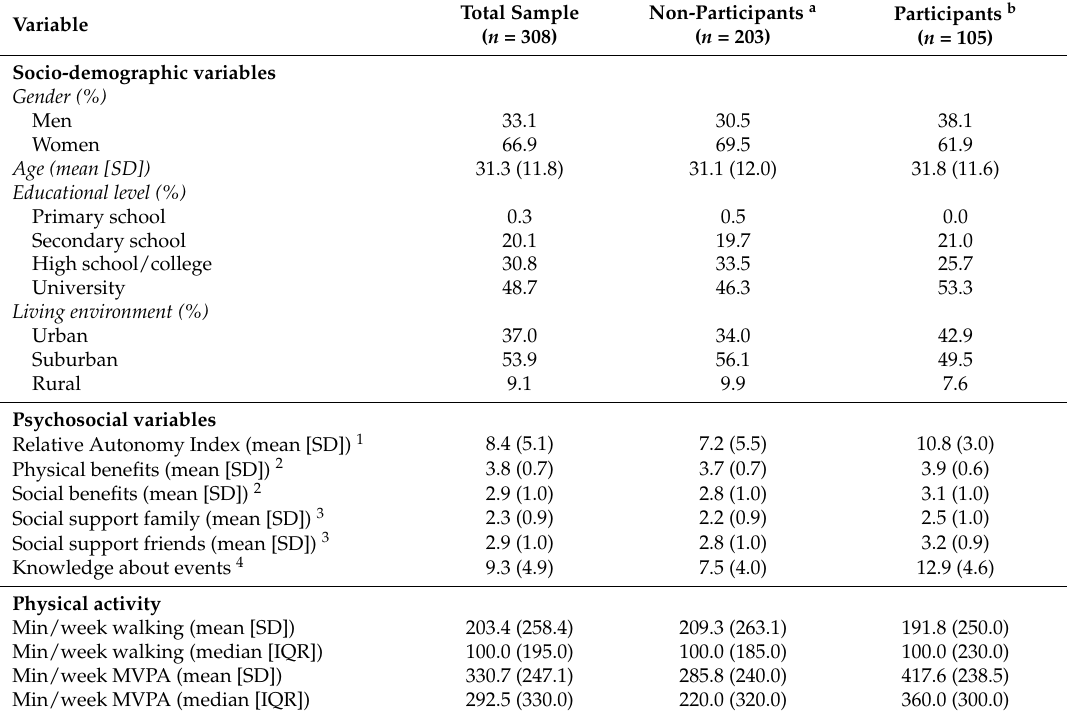
Table 1. Descriptive characteristics of the study